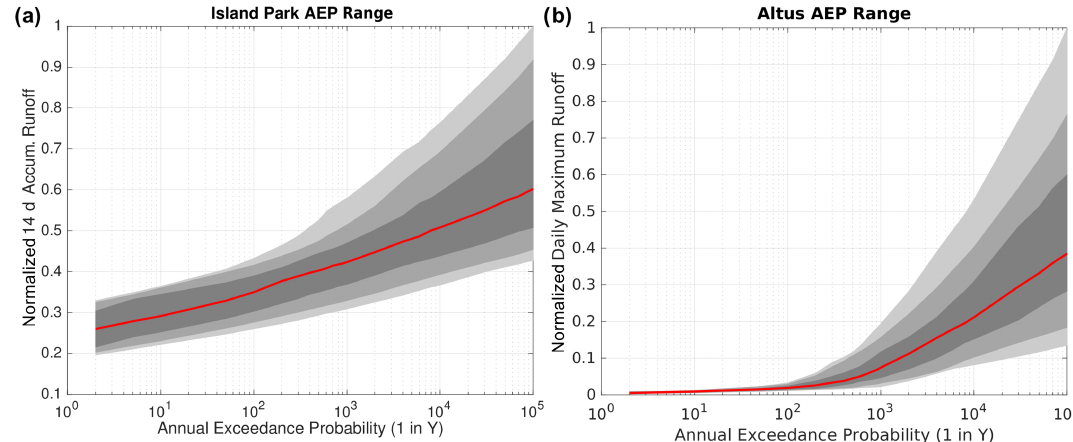
Figure 7. Normalized (by maximum possible flood runoff) FF curves, with the median in red, and the interquartile range (25th–75th per- centiles), in dark gray, the 10th–90th percentile spread, in medium gray, and the minimum to maximum spread, in light gray, for (a) Island Park and (b) Altus.